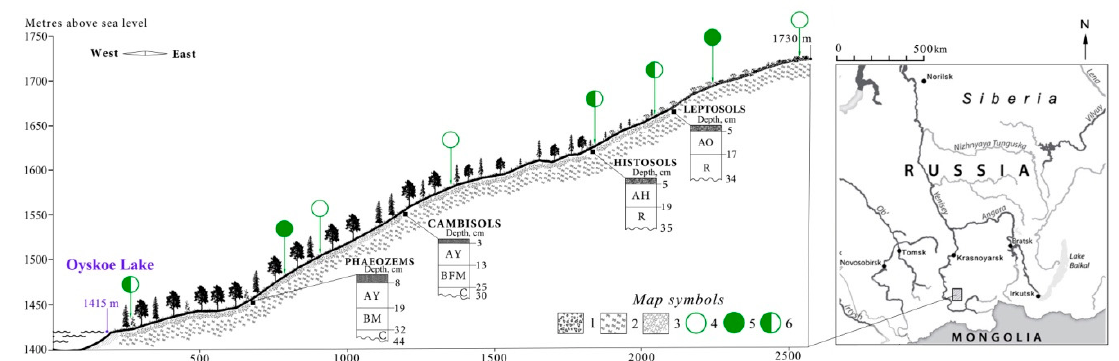
Figure 1. A graphic representation of area of research. The mountain top on the upper right has the coordinates N52.845872, E93.274658. Legend: 1—detritus; 2—metamorphic schist; 3—moraine loam;